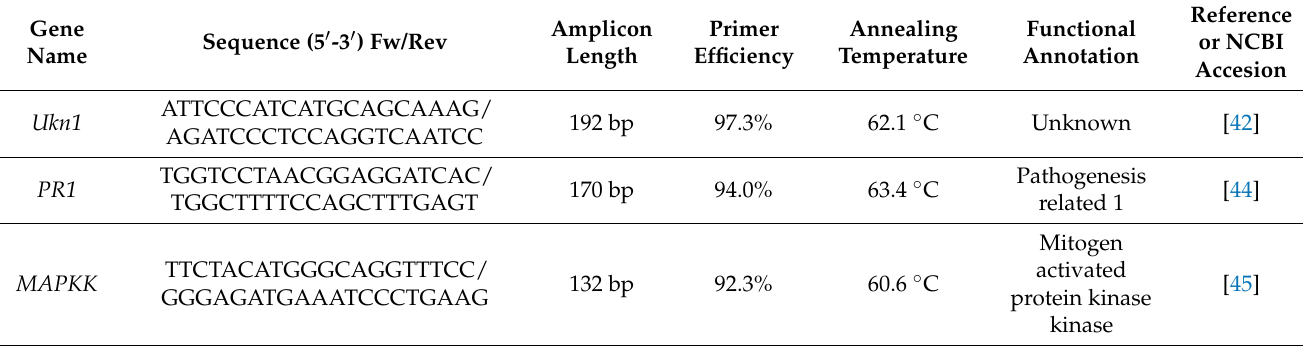
Table 1. Primers used in this work for qRT-PCR analyses, with the sequence, amplicon length, primer efficiency, annealing temperature, functional annotation, and reference or NCBI